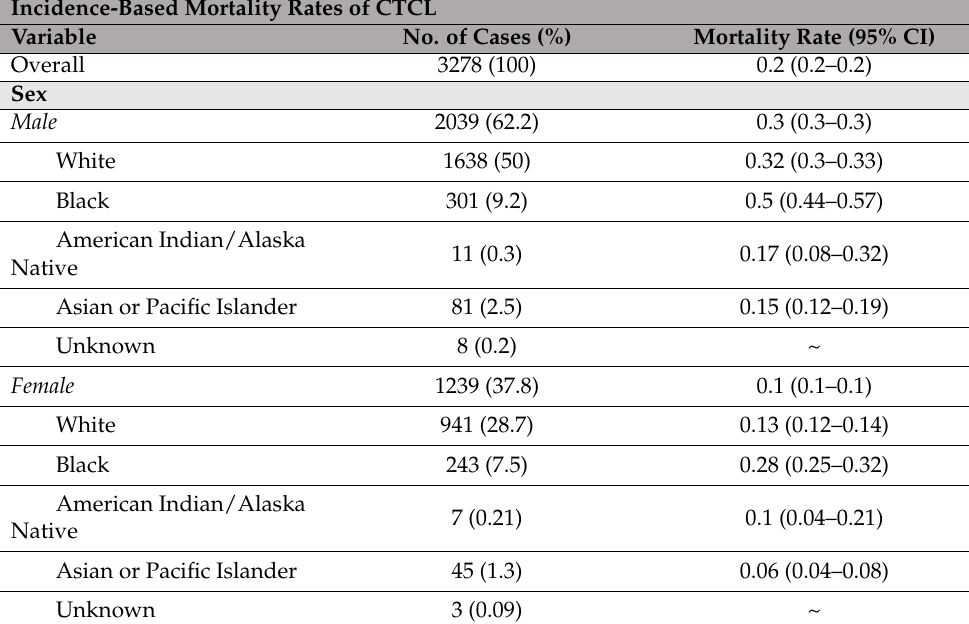
Figure 2. Kaplan–Meier curves of overall survival data stratified by race and sex subgroups. Numbers under the plot indicate the number of patients at risk at a given time. Table 6. National incidence-based mortality rates from